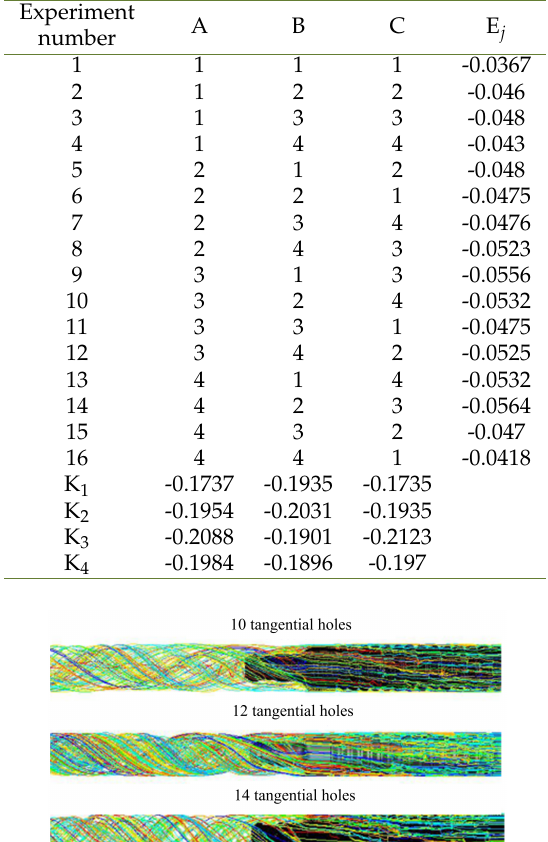
Table 4. Orthogonal test scheme and result analysis table.